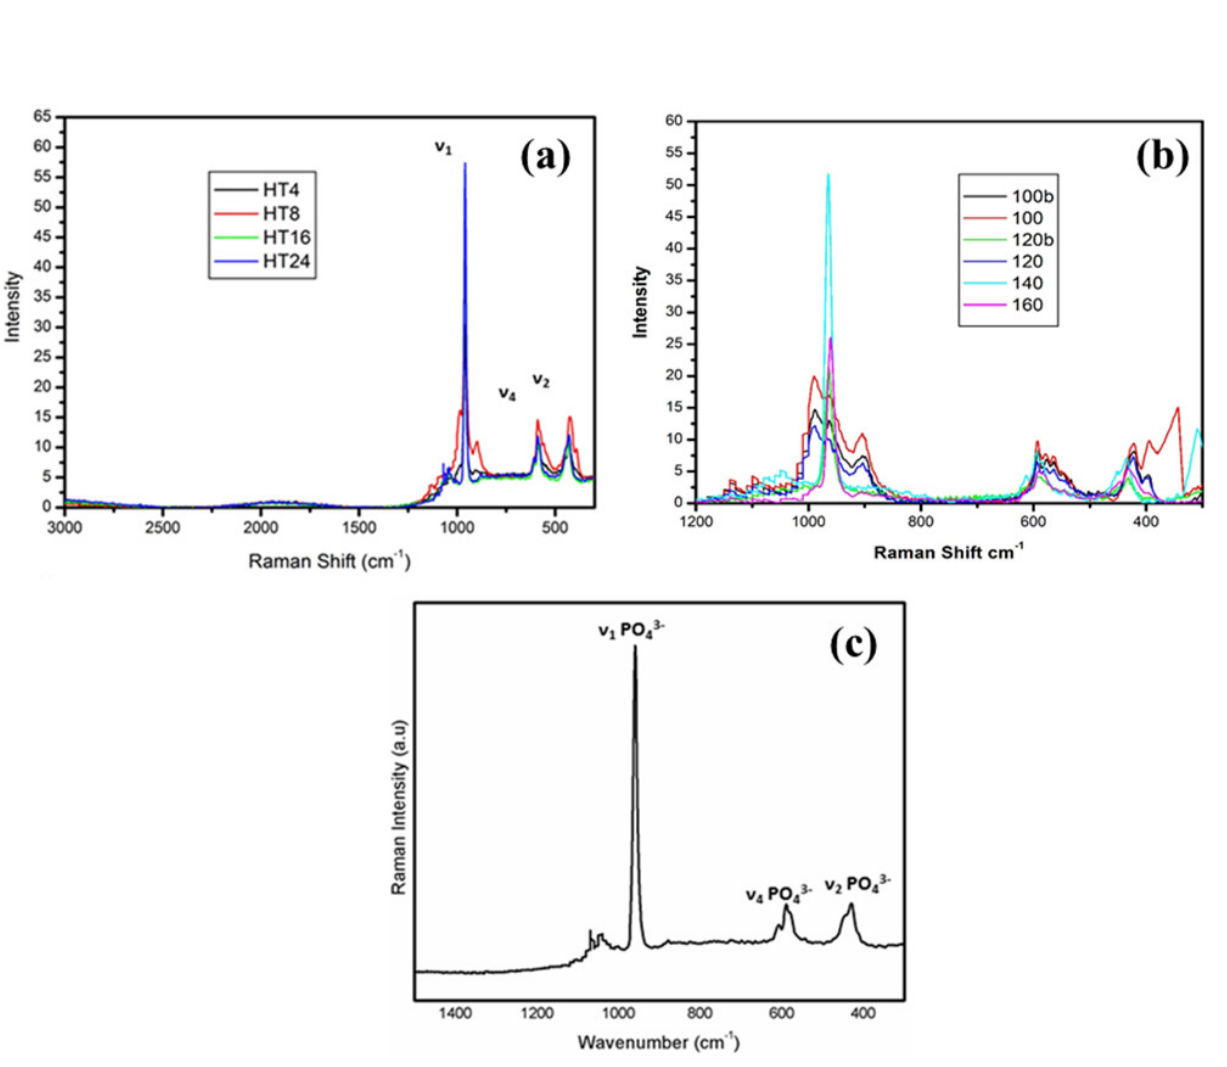
Figure S2: The comparison of the Raman spectra obtained for the formation of nano-hydroxyapatite generated in the different operating conditions of hydrothermal route: (a) Role of dwell time, (b) Effect of temperature and (c) Standard raman reference of